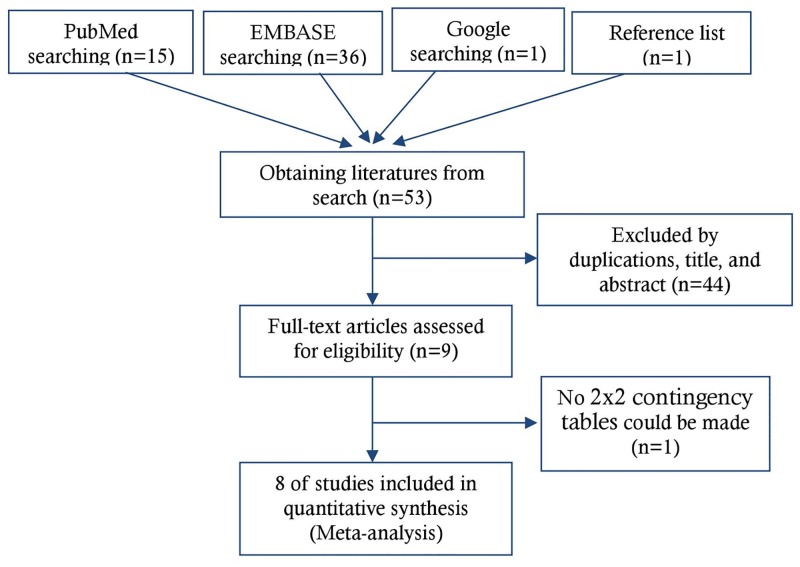
Study identification, inclusion, and exclusion for meta-analysis.